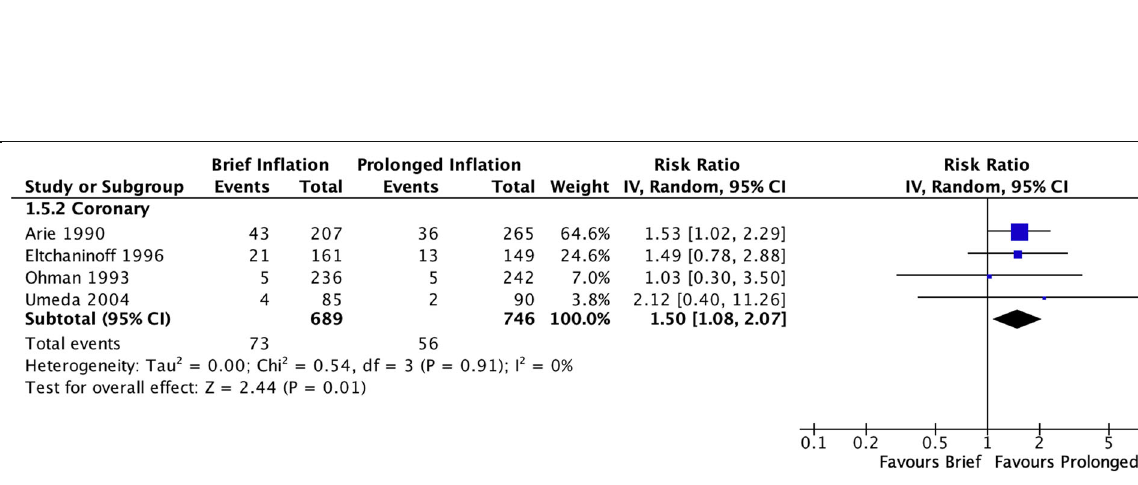
Fig. 7 Risk of residual stenosis on index procedure completion angiogram, following any adjunctive procedures